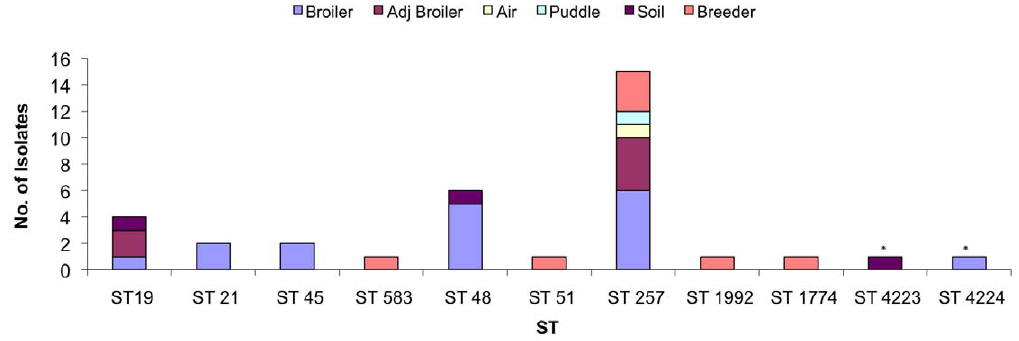
Figure 5. Distribution of STs detected according to source (asterisks signify new STs).